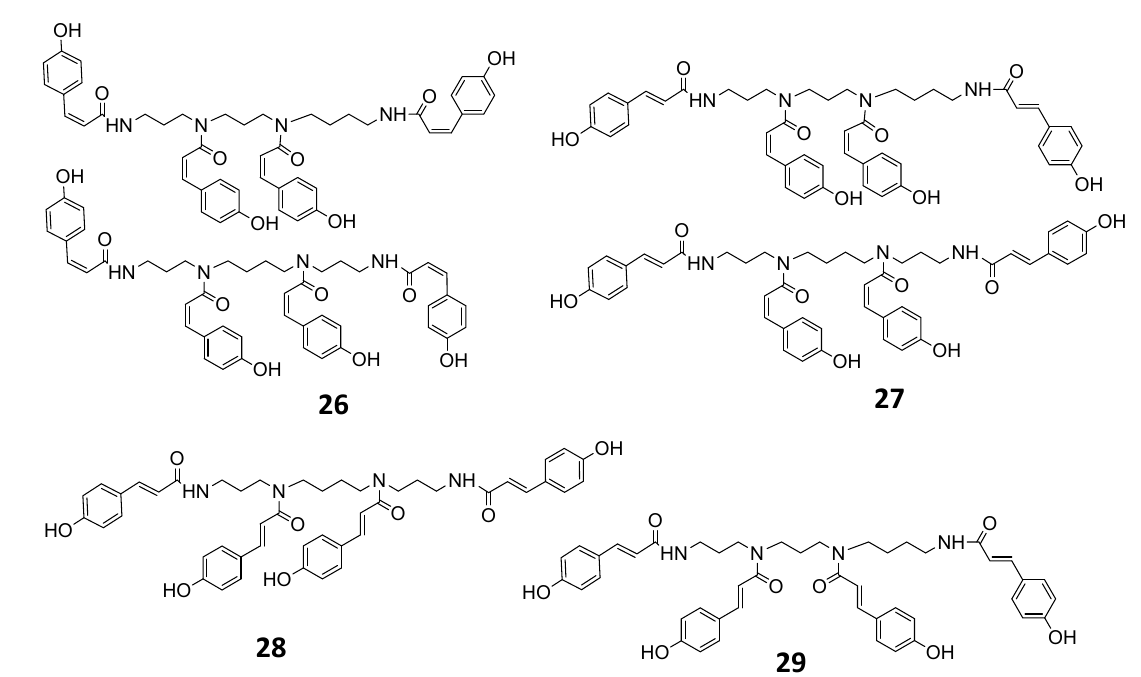
Figure 3. Acylated polyamines detected in Matricaria recutita flowers.